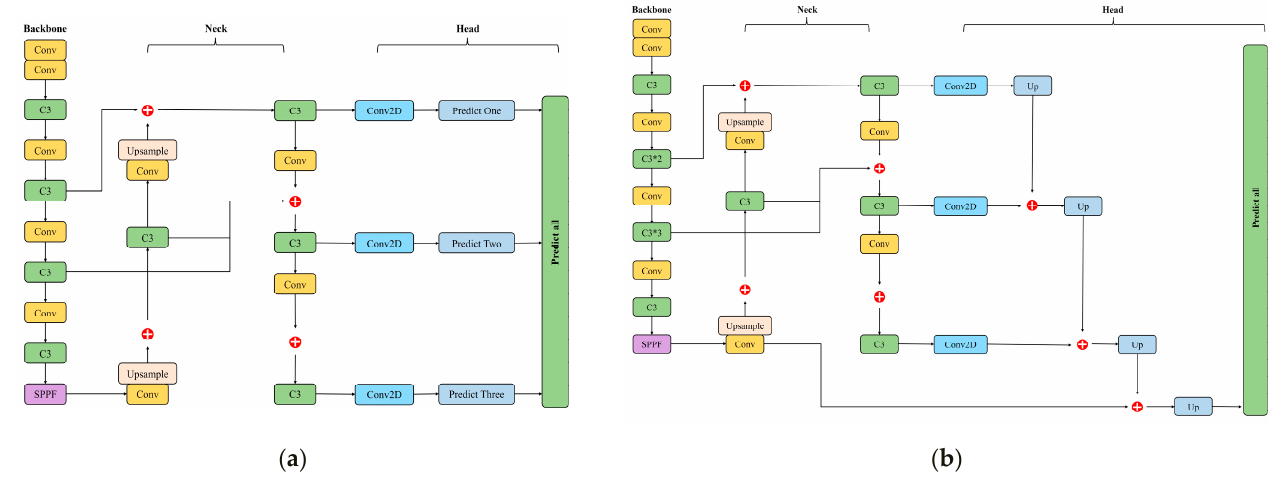
Figure 1. A comparison of YOLOv5x and improved YOLOv5x architecture. ( a ) YOLOv5x; ( b ) improved YOLOv5x.